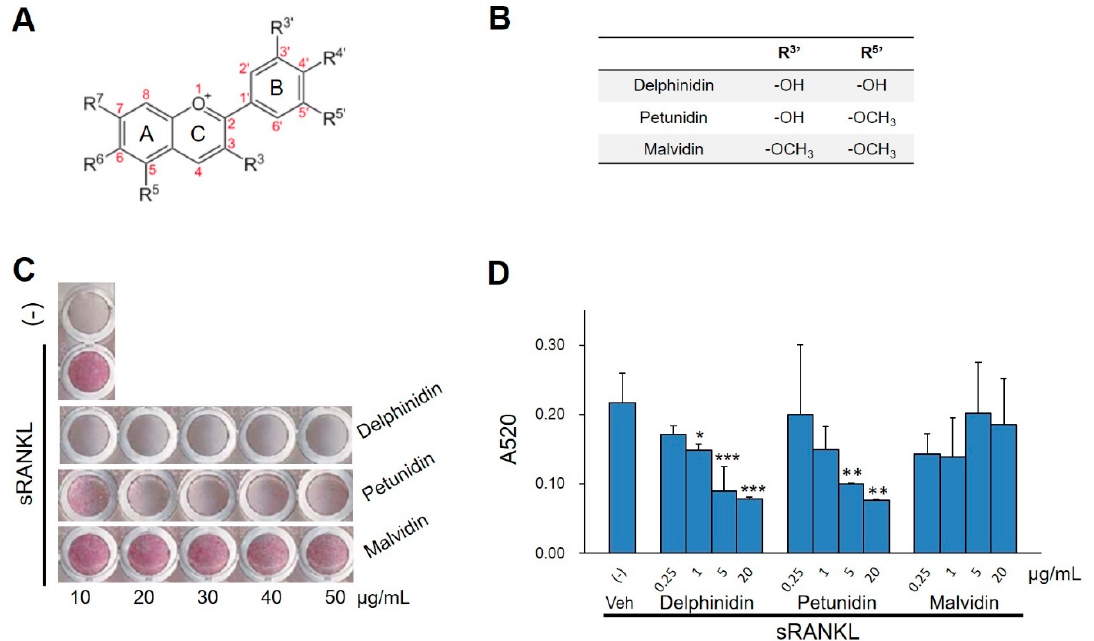
Effects of various anthocyanidins on osteoclastogenesis. ( A ) General structure of anthocyanidins. ( B ) Substituents in the R3 ′ and R5 ′ positions of the anthocyanidins used in the osteoclast formation assay. ( C ) Representative photographs of tartrate-resistant acid phosphatase (TRAP) staining in osteoclast cultures. RAW264.7 cells were pretreated for 1 h with increasing concentrations (10–50 μ g/mL) of three anthocyanidins and cultured for 4 days in the presence of sRANKL (100 ng/mL). ( D ) Anti-osteoclastogenic activity of anthocyanidins was evaluated by the absorbance of the red-stained area per well at 520 nm on a spectrophotometer. Values are expressed in mean ± SD ( n = 4). * p < 0.05, ** p < 0.01, *** p < 0.001 vs. vehicle (Veh).